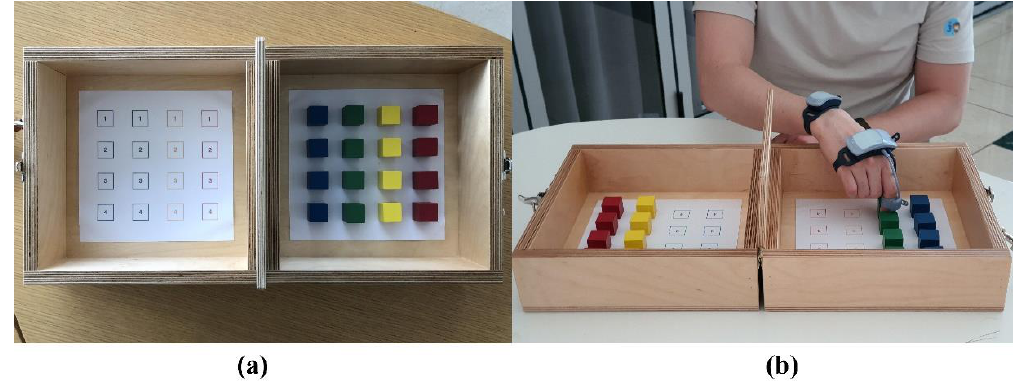
Figure 5. Experimental set-up: ( a ) configuration of the targeted box and block test and ( b ) positioning of the clip-on IMU-system to assess hand and wrist movements.